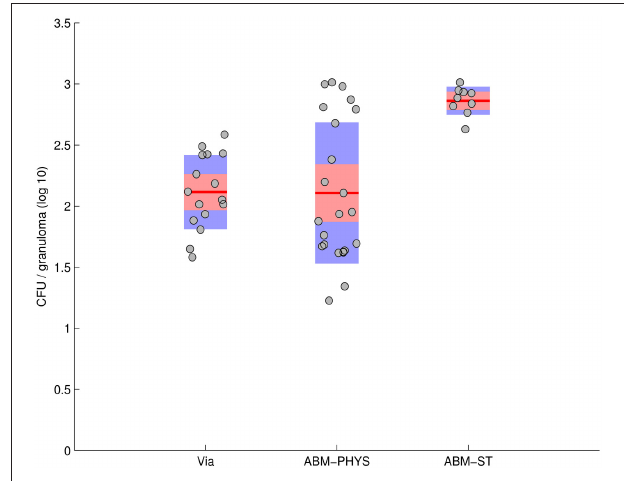
FIGURE 9 | Total CFU for M . bovis untreated infected rabbits on day 63 (Via et al., 2008—bar 1) compared with total CFU resulting from the in silico model of Mtb infection produced by the ABM-PHYS and the ABM-ST model using the same specific growth rate of Mtb for both models. In silico results are based on 10 simulations for ABM-ST and 22 simulations for